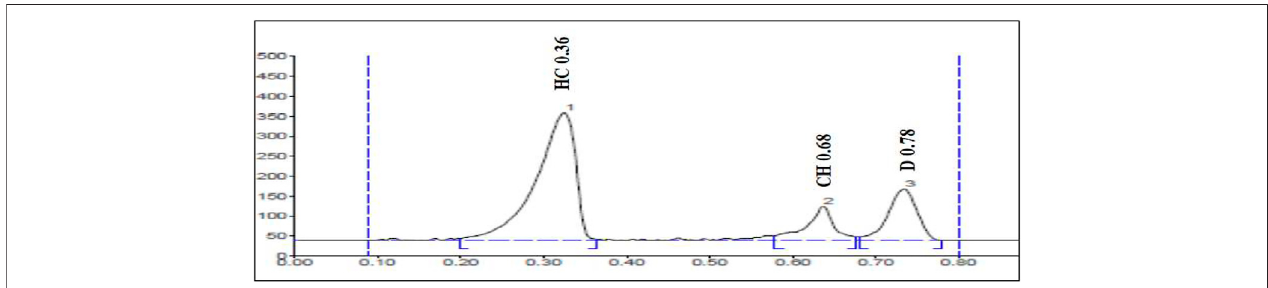
Frontiers in Pharmacology |